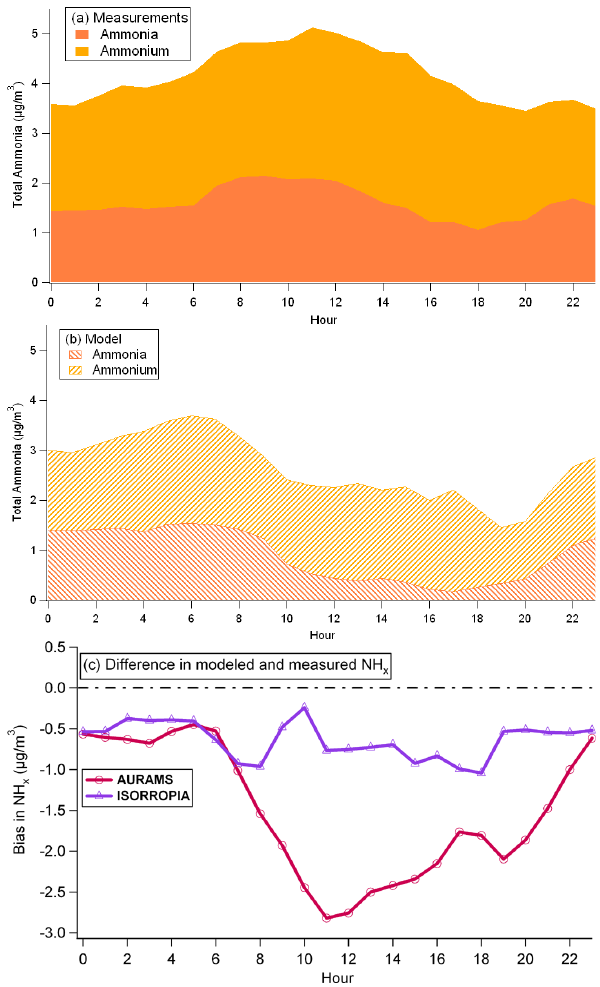
Fig. 5. Stacked plots of the components of total ammonia (top of the trace) for (a) measurements and (b) model. The difference between the modeled and measured NHx is shown in (c) and indicates that the model is biased low in NH x .